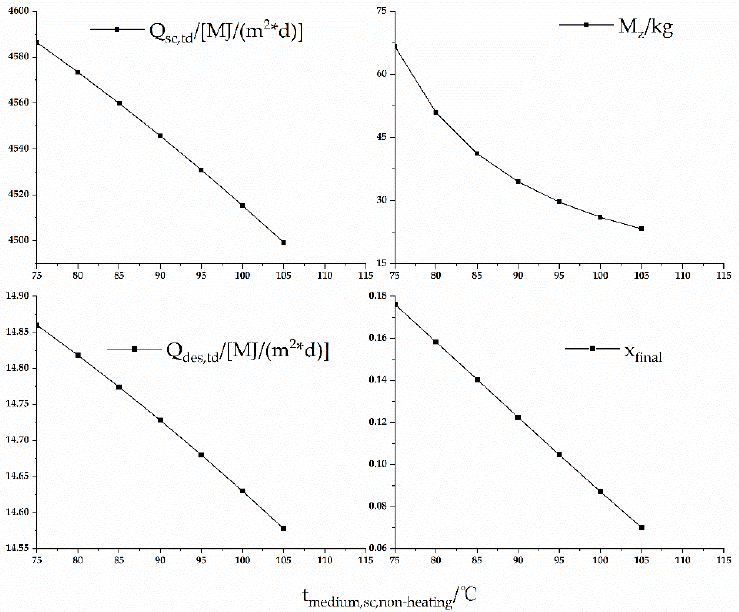
Figure 12. Variations in the key parameters with the medium temperature of solar collection in the non-heating season.